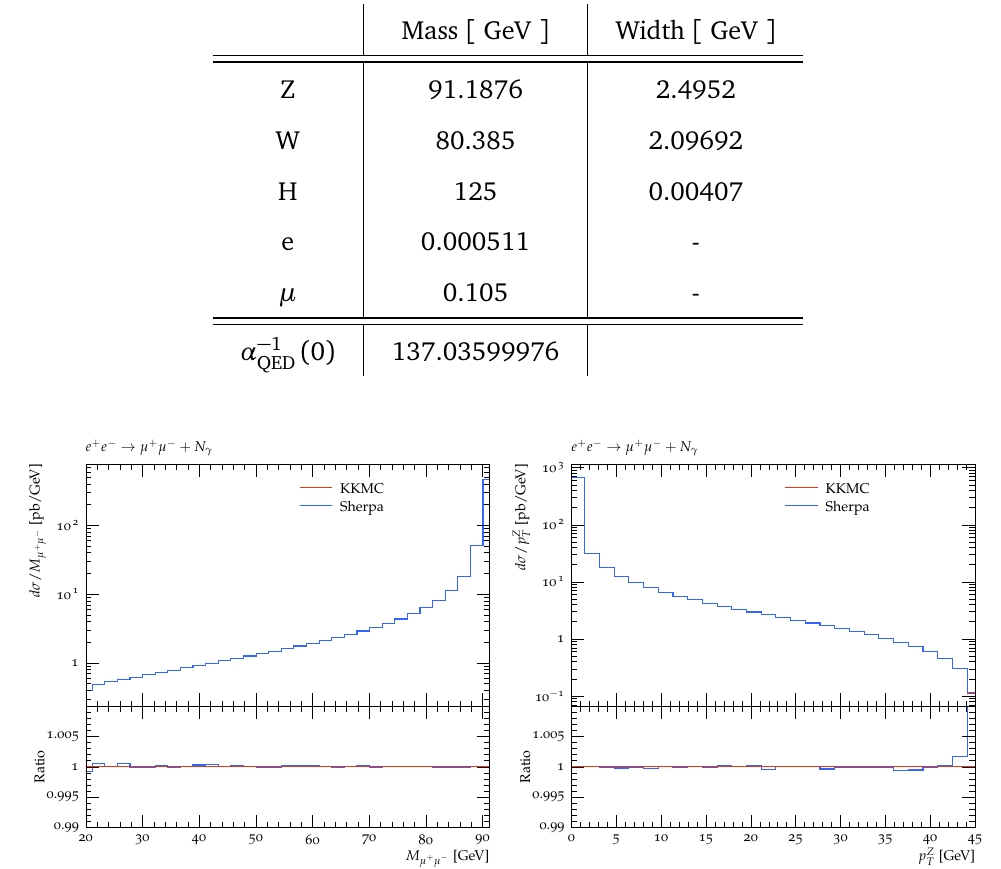
Table 3: Electroweak input parameters in the α ( 0 ) scheme.